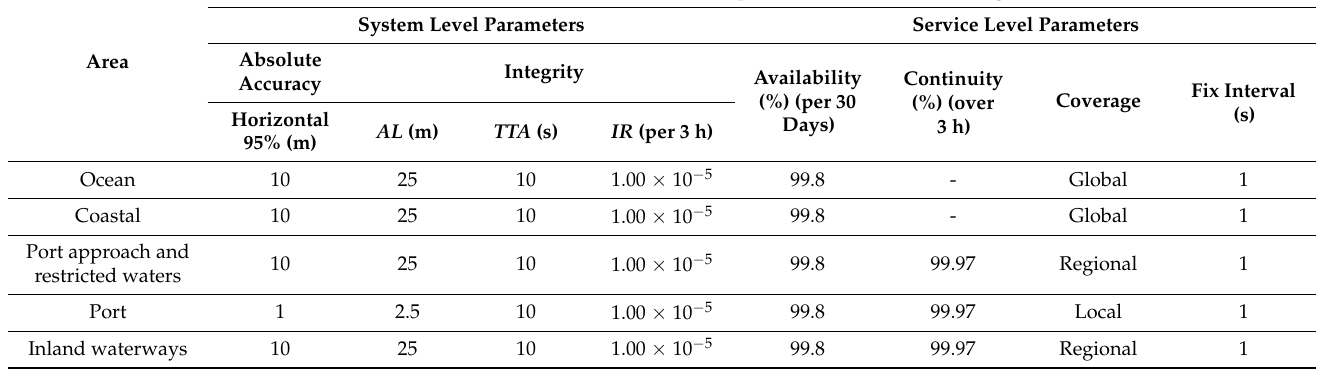
Table 1. Minimum maritime user requirements recommended for general navigation derived from IMO Res. A.915(22) [13].